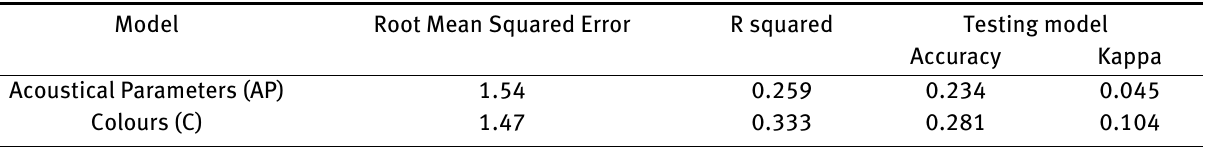
Table 3: Performance of the two linear regression models.